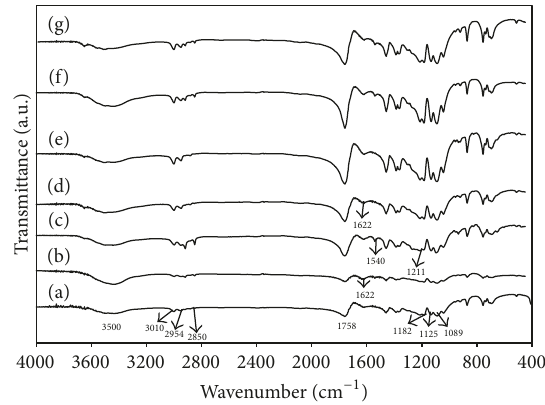
Figure 6: FTIR spectra of PLLA (a) and PLLA nanocomposites (b–g), (b) Zn/Al palmitate (1wt%), (c) Zn/Al palmitate (2wt%), (d) LHS (salicylate) (1wt%), (e) LHS (salicylate) (2 wt%), (f) LHS (palmitate) (1wt%), and (g) LHS (palmitate) (2 wt%).